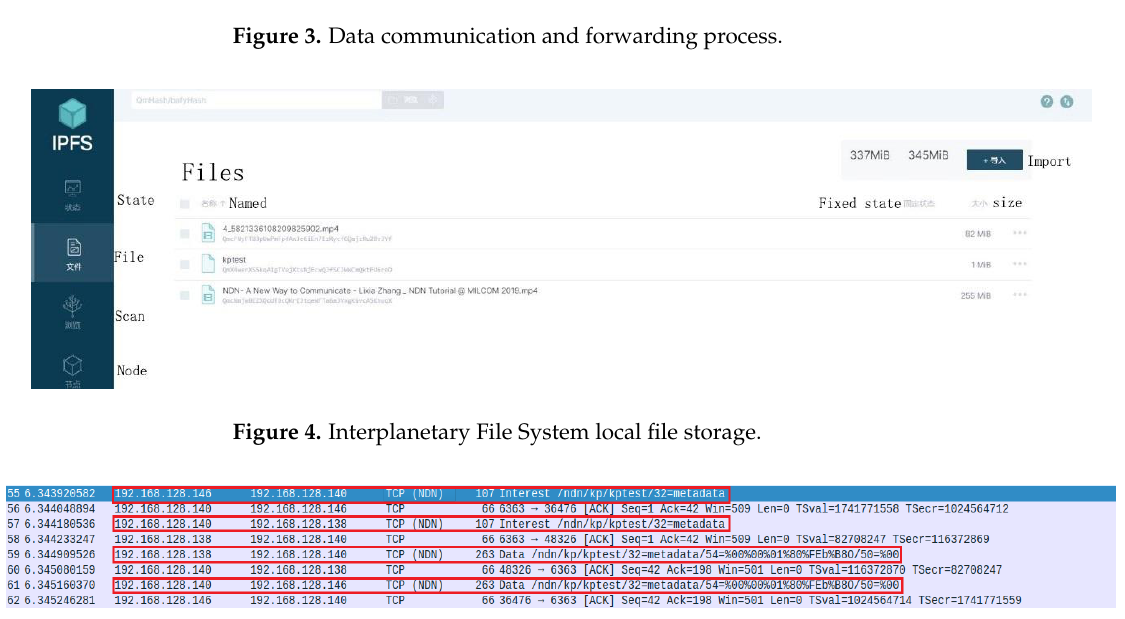
Figure 5. NDN file signature encryption result.